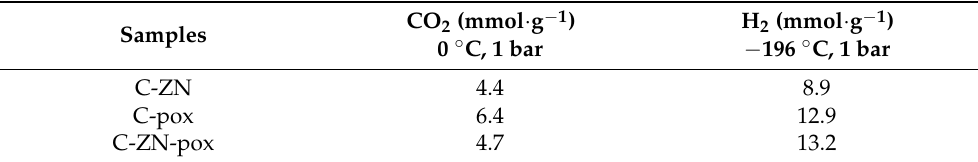
Table 3. Carbon dioxide and hydrogen uptakes for the selected carbon samples.